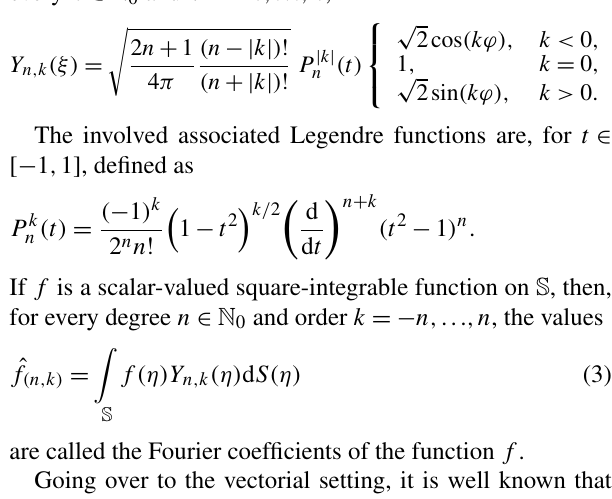
Figure 2. Absolute value of the vectorial Slepian function g ( 3 ) localization over the oceans (b) , for bandlimit N =